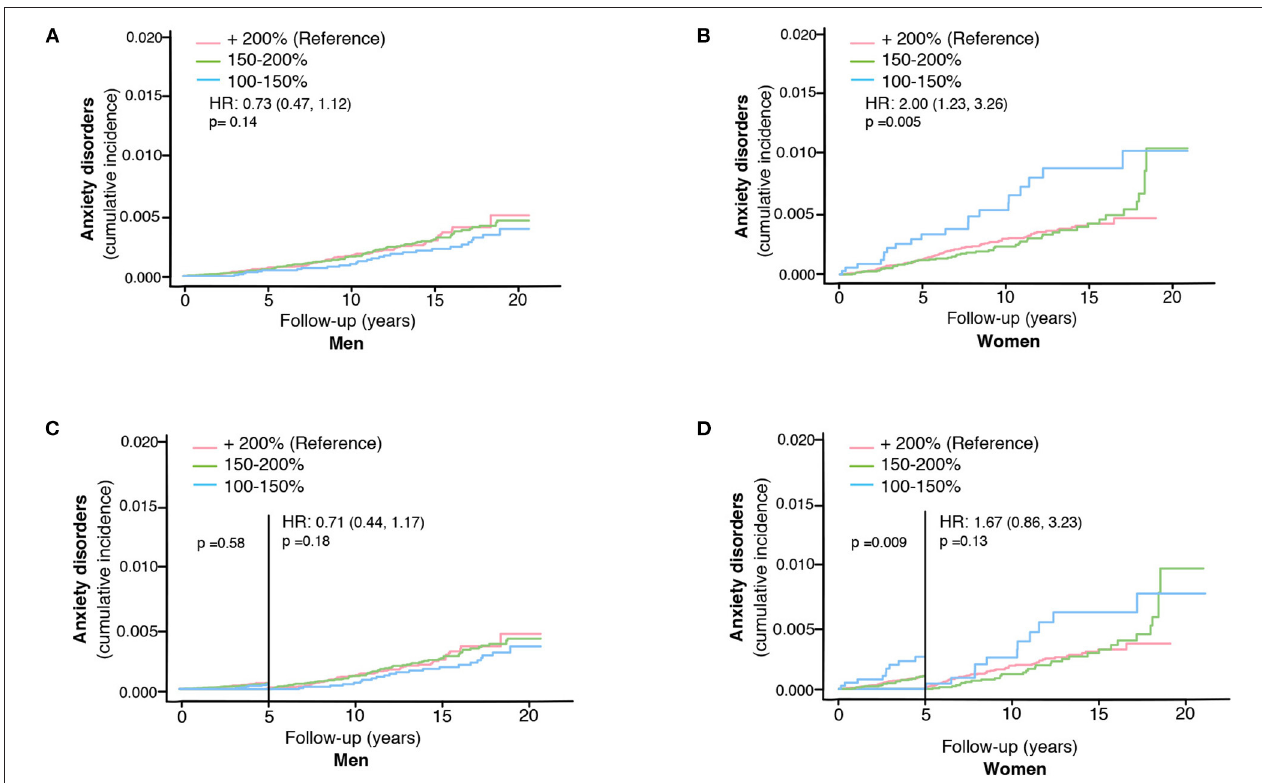
FIGURE 3 | The impact of ski race finishing time on the risk of developing anxiety disorders in skiers in men (A) and women separately (B) . The impact of ski race finishing time on the risk of developing anxiety disorders more than 5 years after completing the ski race in men (C) and women (D) . HR represents hazard ratios from an unadjusted cox regression for the fastest (100–150% of winning finishing time) group, using + 200% as the reference